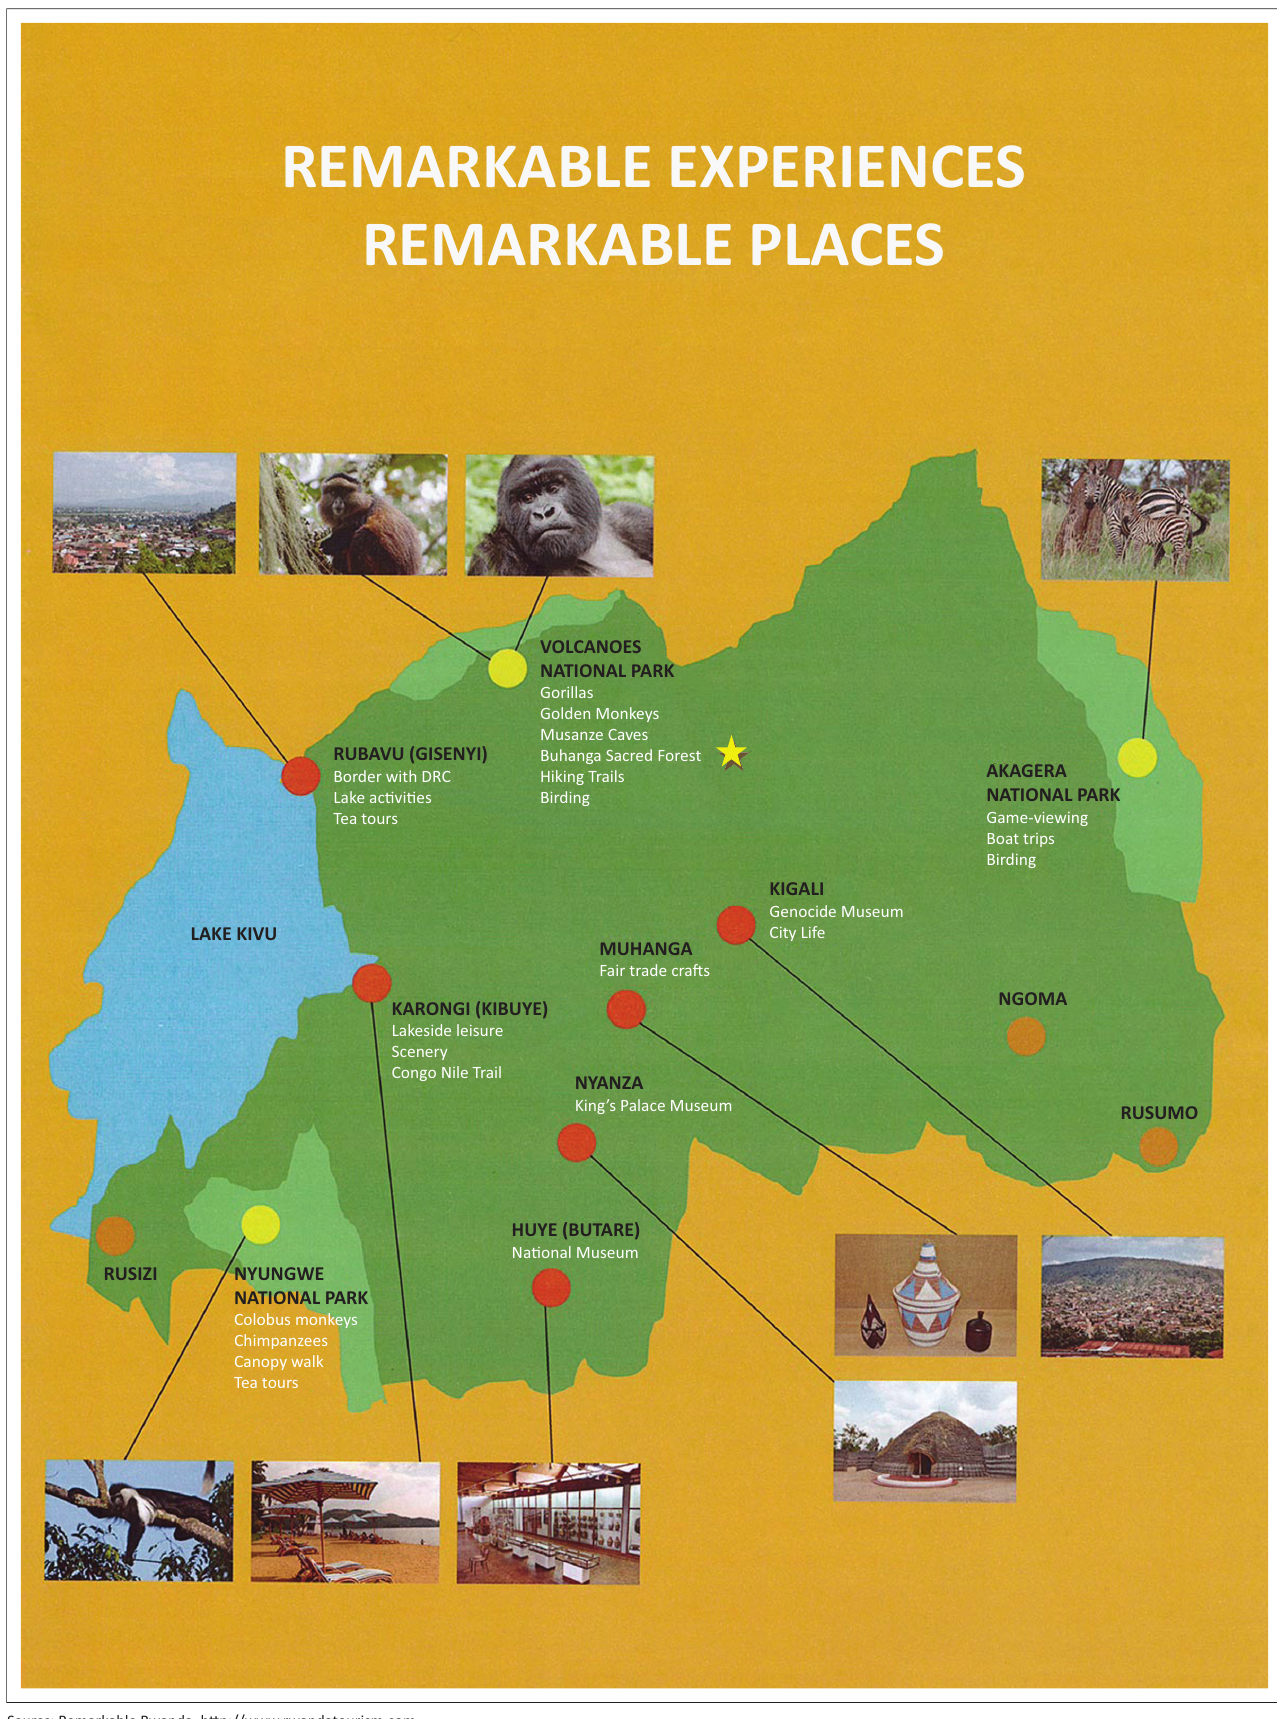
FIGURE 2-A1: Remarkable places in